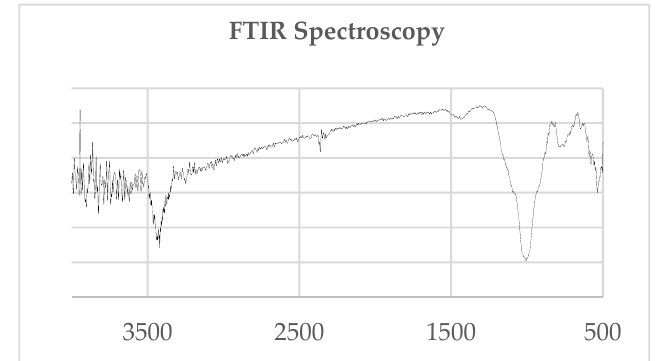
Figure 1. FTIR spectra of zeolite.